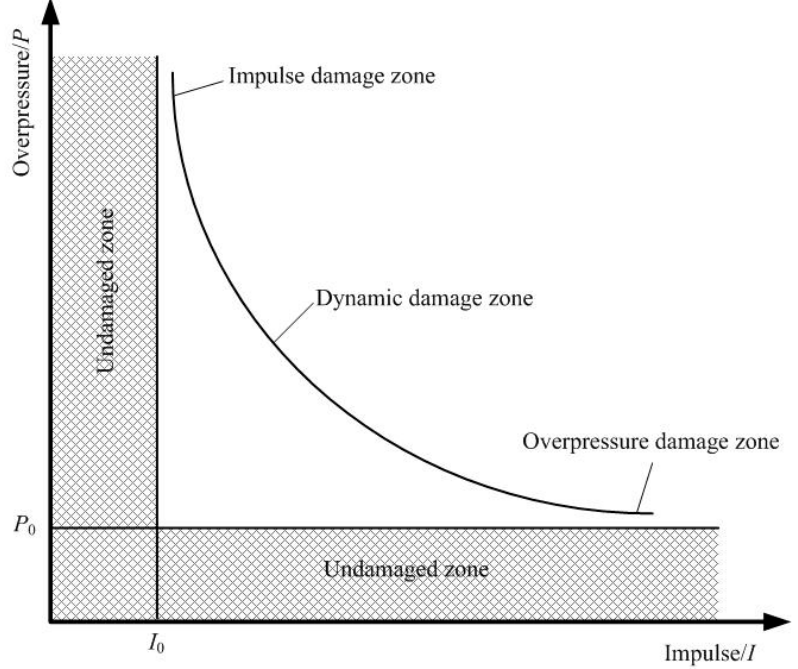
Figure 1. Schematic diagram of a P - I curve.